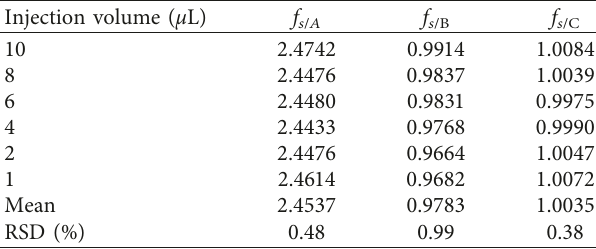
Figure 2: Chromatograms of the standard solutions and sample solutions. (a) Mixed standard solution; (b) sample solution; (1) mag- noflorine; (2) jatrorrhizine hydrochloride; (3) palmatine hydrochloride; (4) berberine hydrochloride. Table 3: Taking the berberine hydrochloride as the internal standard to calculate the RCF values.